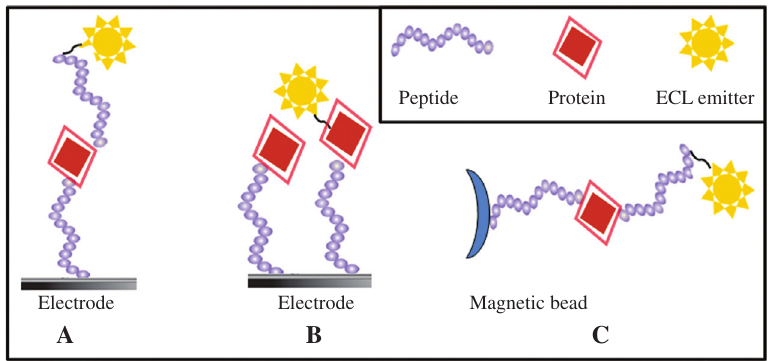
Figure 1 Scheme of possible configurations of the ECL peptide-based bioassay in the binding model. (A) sandwich assay; (B) competitive assay; (C) magnetic bead-based homogeneous